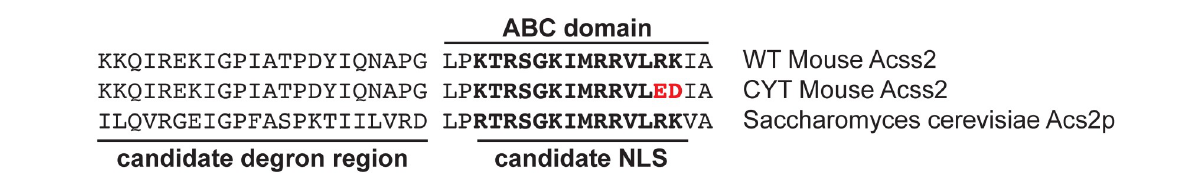
Fig 7. The Acss2 hinge region contains multiple candidate functional domains. Alignment of mouse WT Acss2 protein, mouse ED Acss2 protein, and Saccharomyces cerevisiae Acss2 homolog Acs2p protein reveals a candidate degron region as well as a candidate nuclear localization signal (NLS) encompassed in the Acss2 basic residue-rich conserved domain (ABC